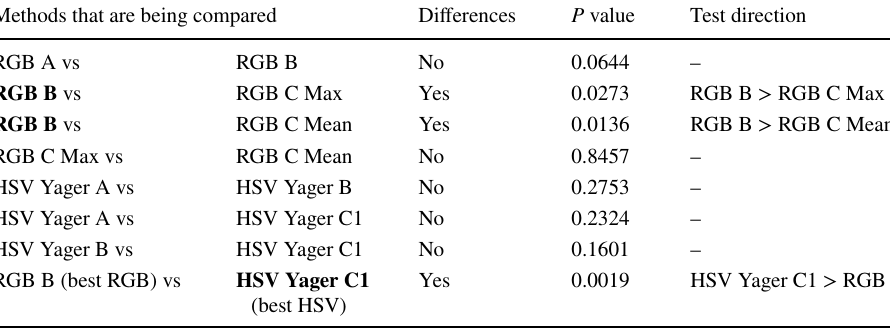
test with continuity correction between the aggregation methods ( Canny